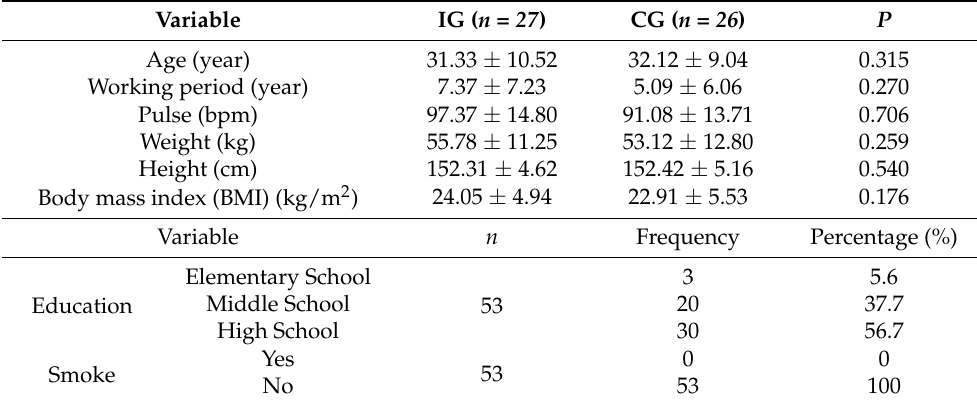
Table 1. Distribution of garment-sewing operator characteristics ( n =